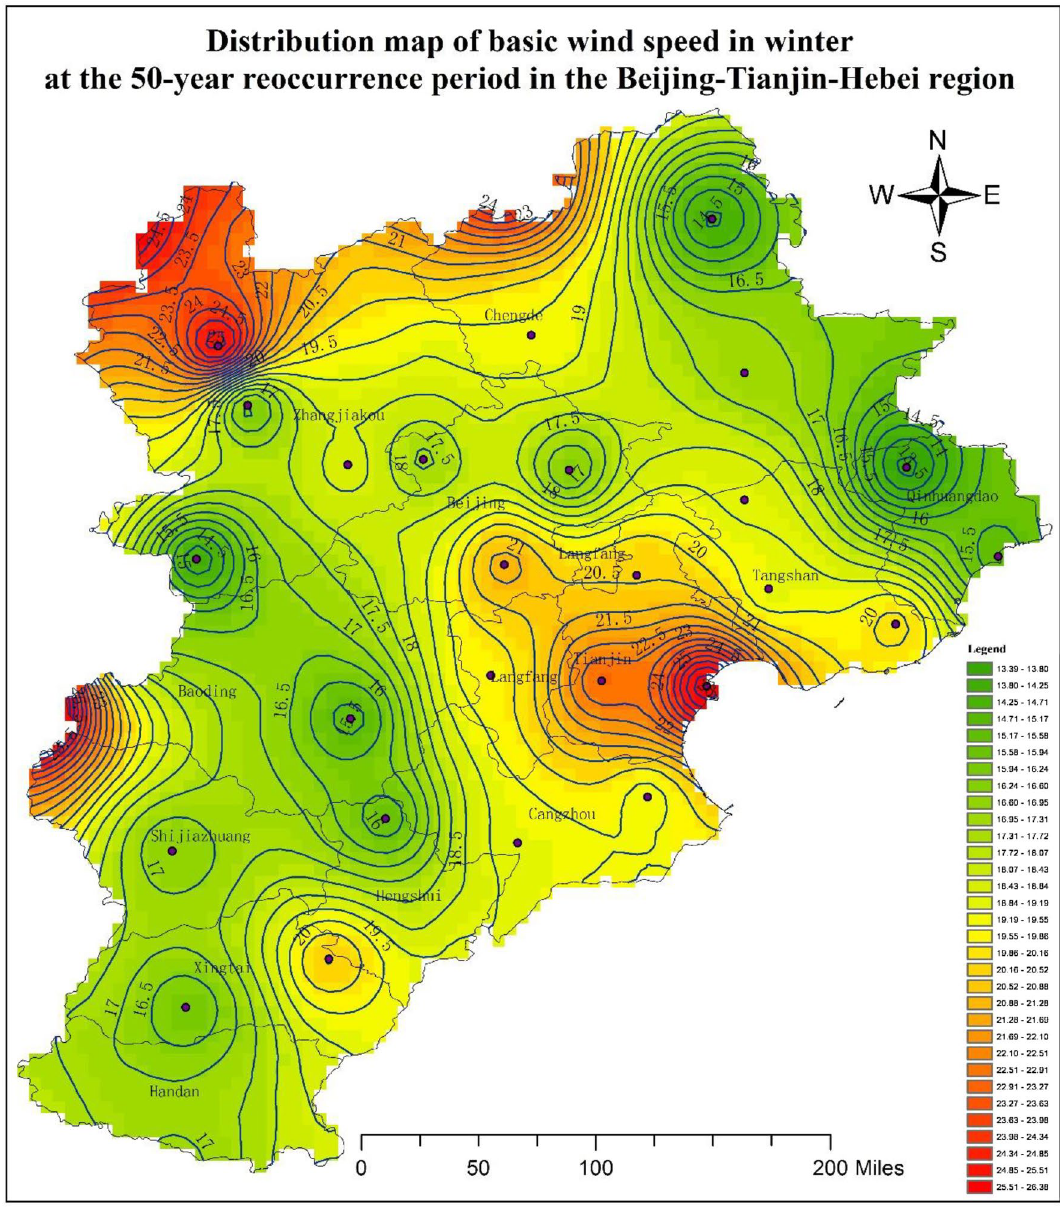
Figure 4. Distribution map of the basic wind speed in winter at the 50-year reoccurrence period in the Beijing– Tianjin–Hebei region. The present map was done by using ArcGIS 10.0 desktop version (https ://www.esri.com/ zh-cn/arcgi s/produ cts/arcgi s-pro/overv